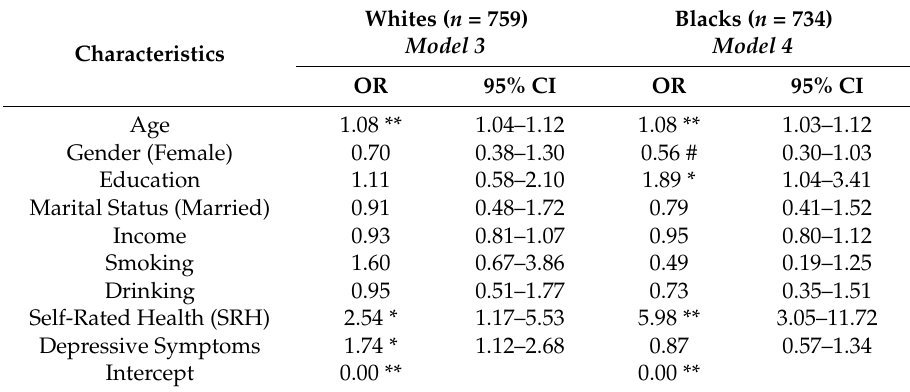
Table 3. Association between baseline depressive symptoms (2001) and all-cause mortality (2001–2004) using logistic regression among Whites ( n = 759) and Blacks ( n =